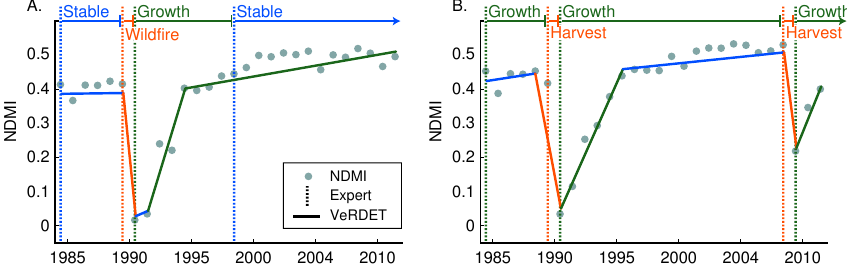
Figure 9. Comparison of VeRDET segmentation (solid lines) and labeling (disturbance: orange, stable: blue, regenerating: green) to expert segmentation (vertical dashed lines) with values from summertime composites for two evaluation pixels, a wildfire event showing off-by-one-year errors in disturbance detection ( A ) and a repeated harvest illustrating disagreement on ‘stability’ versus ‘growth’ after rapid spectral recovery ( B